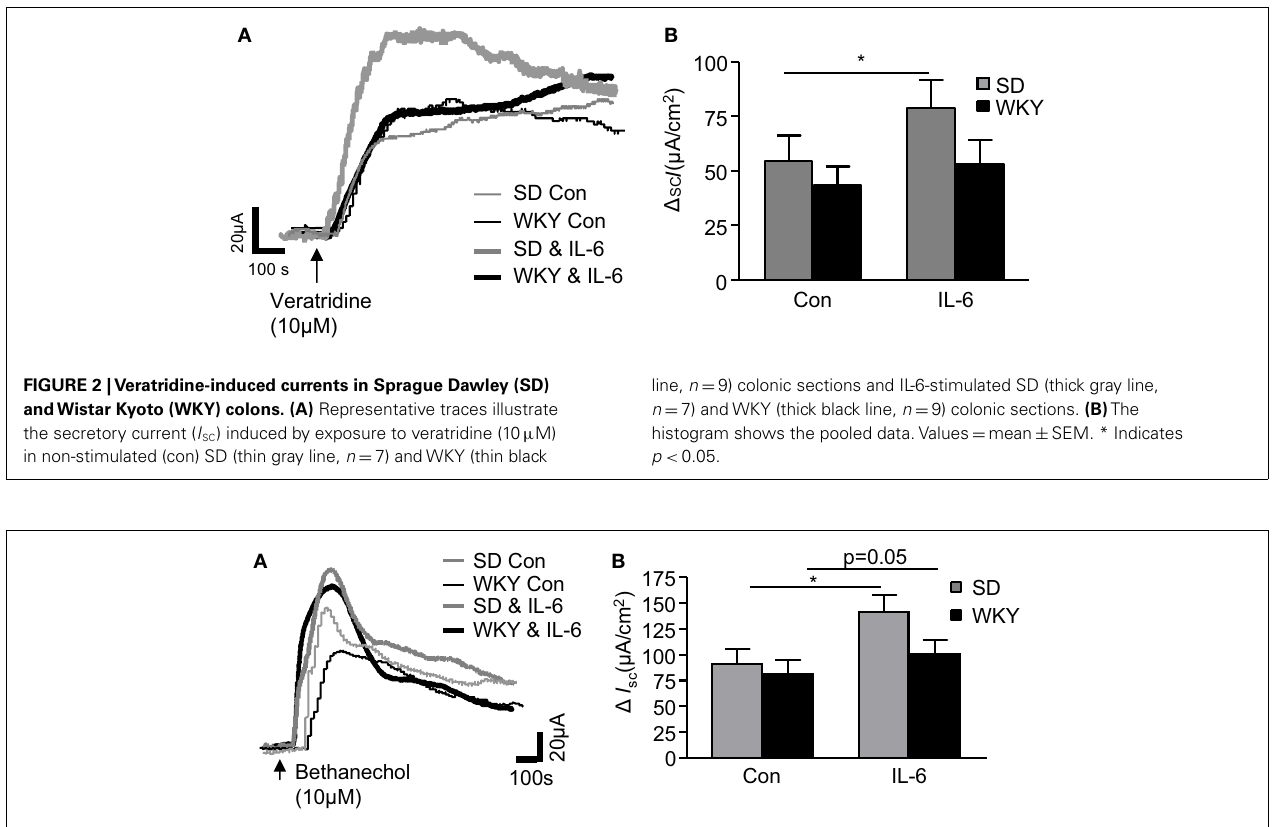
FIGURE 3 | Cholinergically driven currents in Sprague Dawley (SD) and Wistar Kyoto (WKY) rats are altered by IL-6 exposure. (A) The representative traces show bethanechol-induced increases in short circuit current ( I SC ) in control (Con, thin gray line, n = 12) and IL-6-(1nM) stimulated